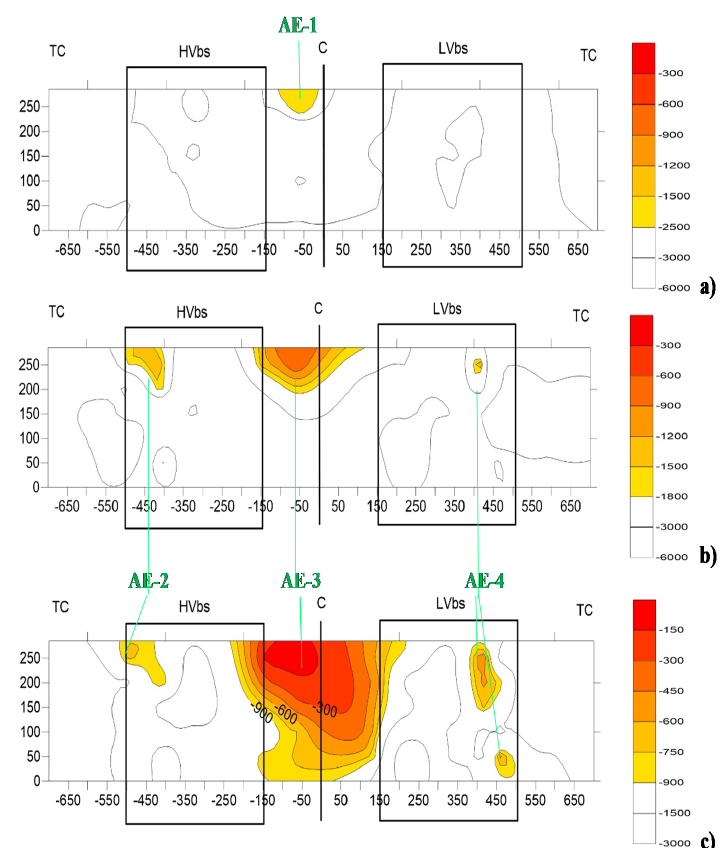
Figure 4. Maps of the ADC descriptor values on the lateral walls of the tank of the tested transformer within the chosen frequency bands: ( a ) 100–200 kHz; ( b ) 60–100; ( c ) 20–60 kHz with the localized areas AE-1, AE-2, AE-3, and AE-4. Description of the points within the maps: (X; Y) in centimeters - coordinate of the points at the side walls of the tested transformer tank: X- position running along the transformer tank, (0-the point opposite to the center of the tap changer (TC), positive X values for part of the tank from the low voltage bushing side (LVbs), negative X values for part of the tank from the high voltage side (HVbs), Y-height running up the tank (0-bottom of the